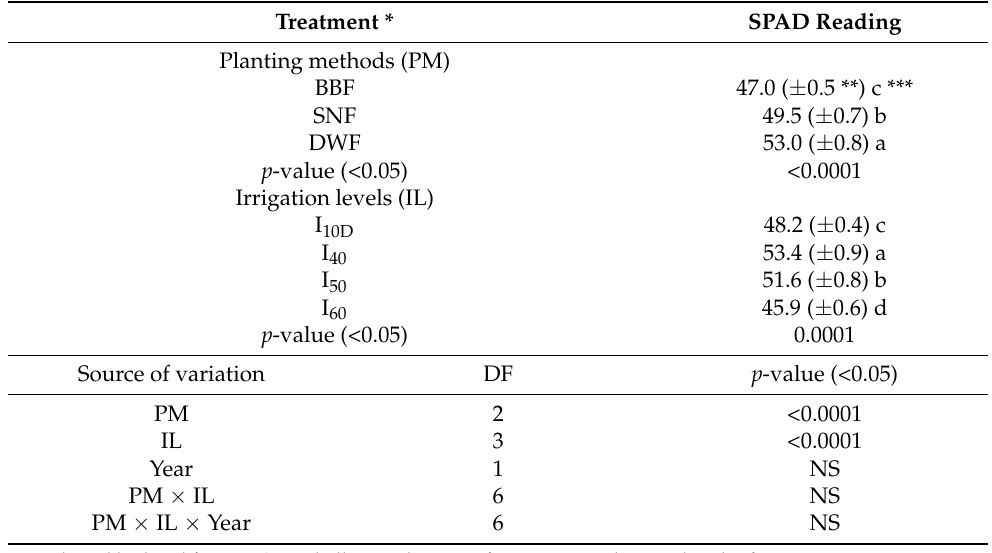
Table 3. Effect of planting methods, irrigation levels, and year on SPAD reading of maize at 90 DAS in Dharwad, India.